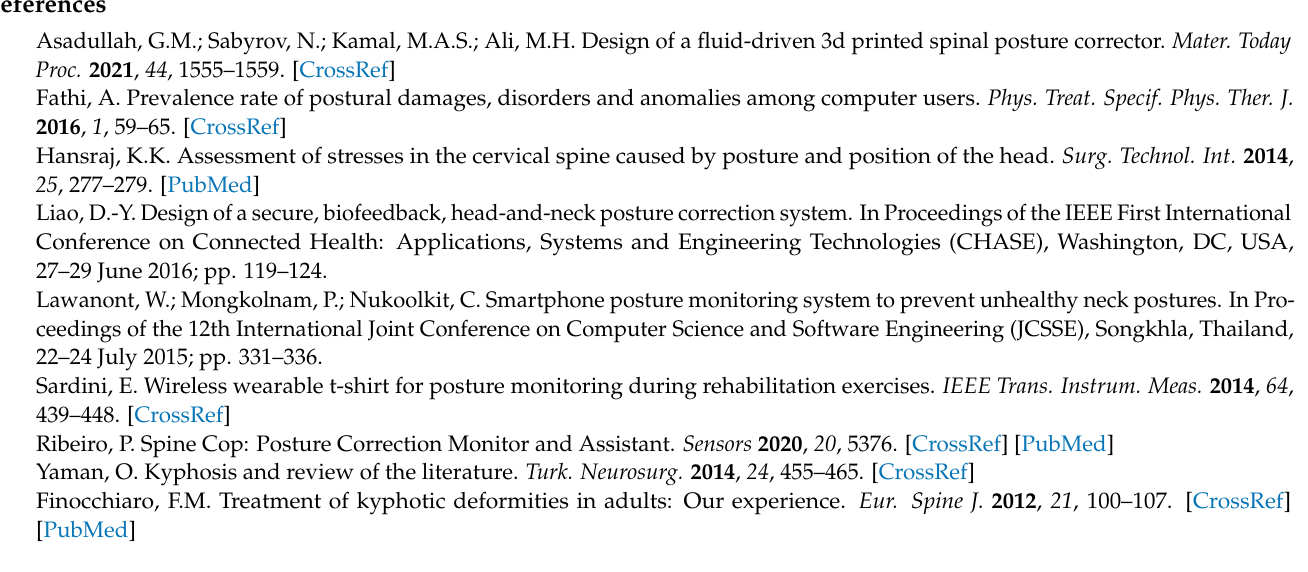
Figure A2. The observed data, showing the co-relation between pressure and angle at 3 N–7 N